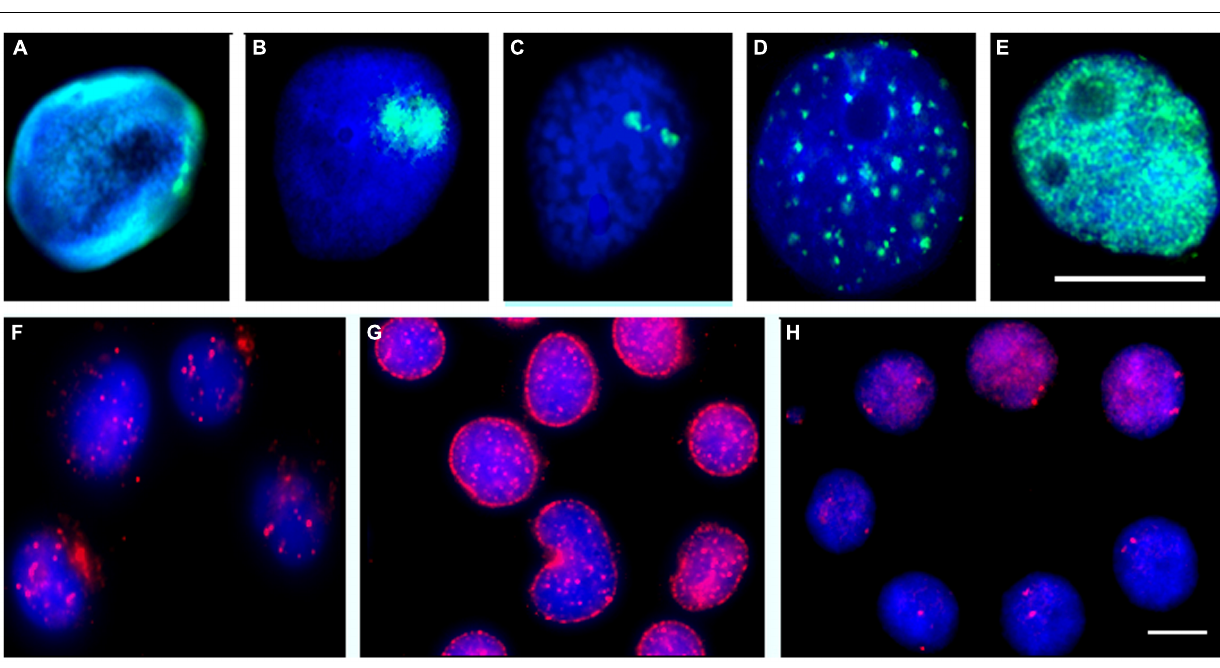
K4 ( E , green). Individual chromosome territories were delineated by allowing 5-bromo-2 (cid:2) -deoxyuridine to be incorporated into replicating DNA and then allowing cells to divide seven times, followed by indirect immunofluorescence with an anti-5-bromo-2 (cid:2) -deoxyuridine antibody ( C , red). Individual gene loci were revealed by FISH using labeled BAC probes ( H , red).The DNA of the cells was stained with a DNA intercalating dye 4 (cid:2) 6-diamidino-2-phenylindole. Scale bar 10 μ m (Drs. Arican-Goktas, 2013 and Odoemelams (cid:2) , 2009, Ph.D. thesis, Brunel University, UK) (Odoemelam, 2009; Arican-Goktas,